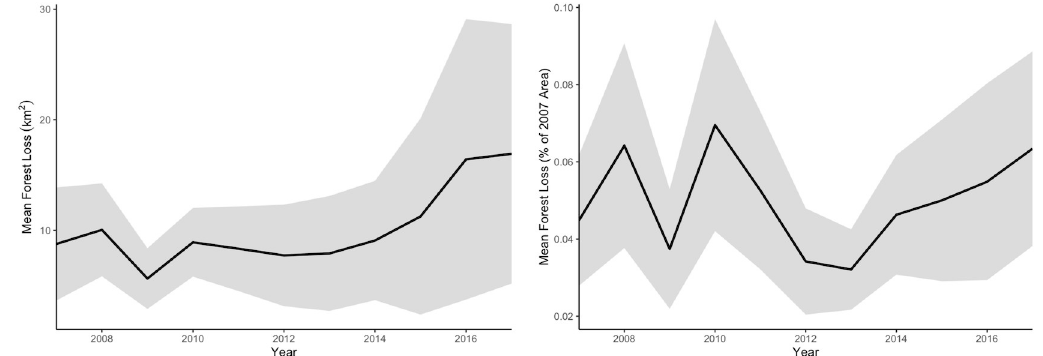
Fig 2. Annual forest loss in Amazonas 2007–2017 (left: km 2 , right: % of 2007 area; shaded areas indicate 95% confidence intervals).